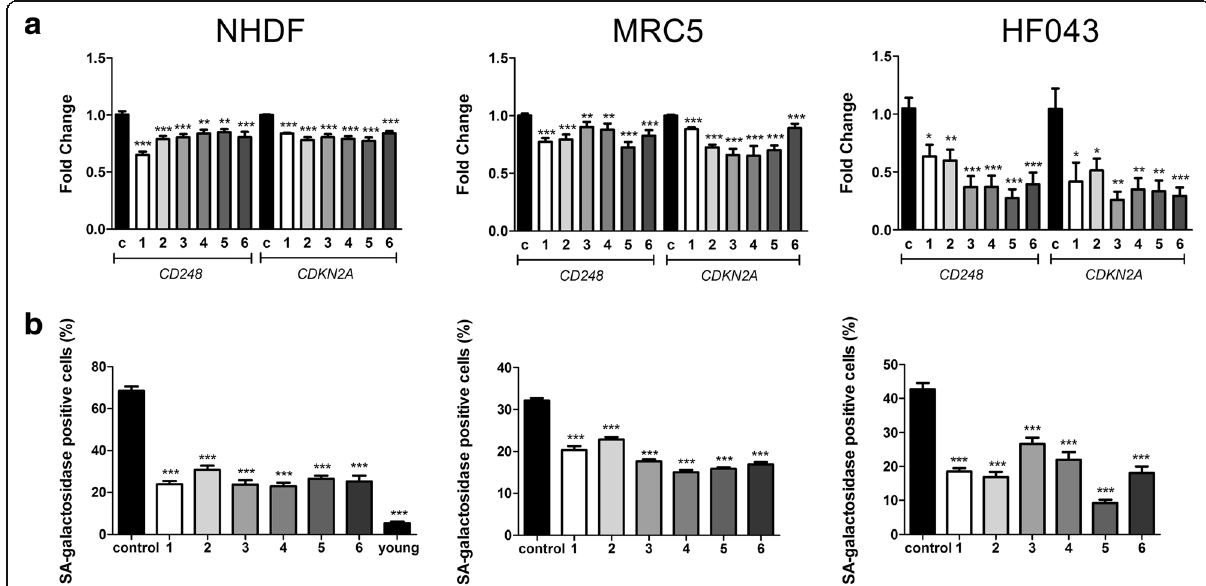
Fig. 4 Decreased senescence biomarkers on resveralogue treatment ( a ) Levels of senescence-associated transcripts CDKN2A and CD248 were assessed in senescent populations of NHDF, MRC5 and HF043 fibroblasts by quantitative reverse transcription PCR. Data are expressed relative to stable endogenous control genes GUSB, IDH3B and PPIA, and normalised to the levels of the individual transcripts in untreated controls (c), 1 – 6 = resveralogues 1 – 6 . Fold change was calculated for in triplicate for three biological replicates ( b ) Senescence associated β - galactosidase following treatment with resveralogues 1 – 6 was determined by manually counting the percentage of SA- β gal positive cells (NHDF, MRC5 and HF043) in each treated or control population. n > 300 for each sample. Statistical significance is indicated